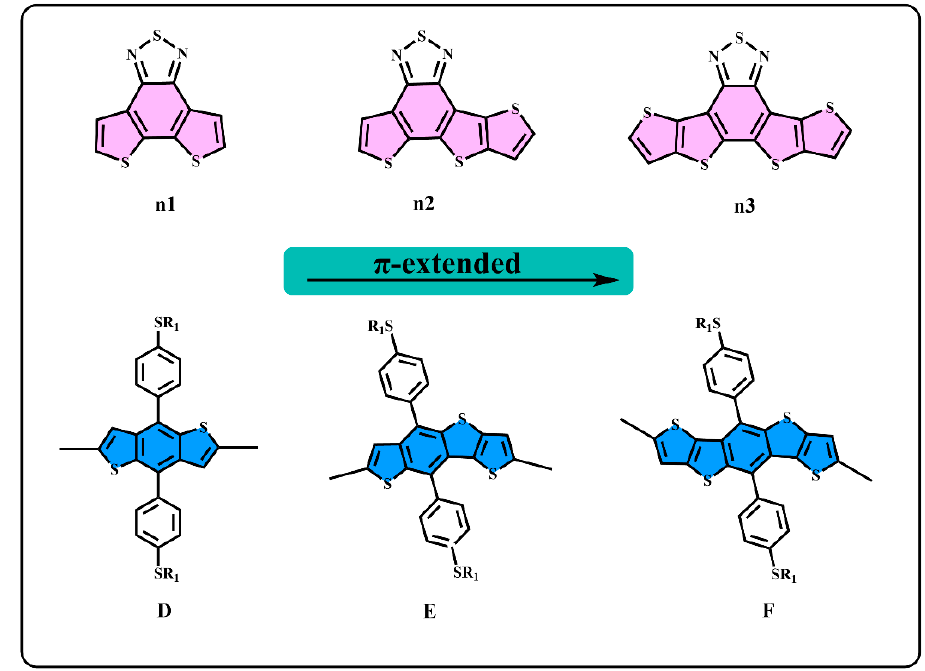
Figure 1. The structure of n1, n2, n3, D, E, and F.